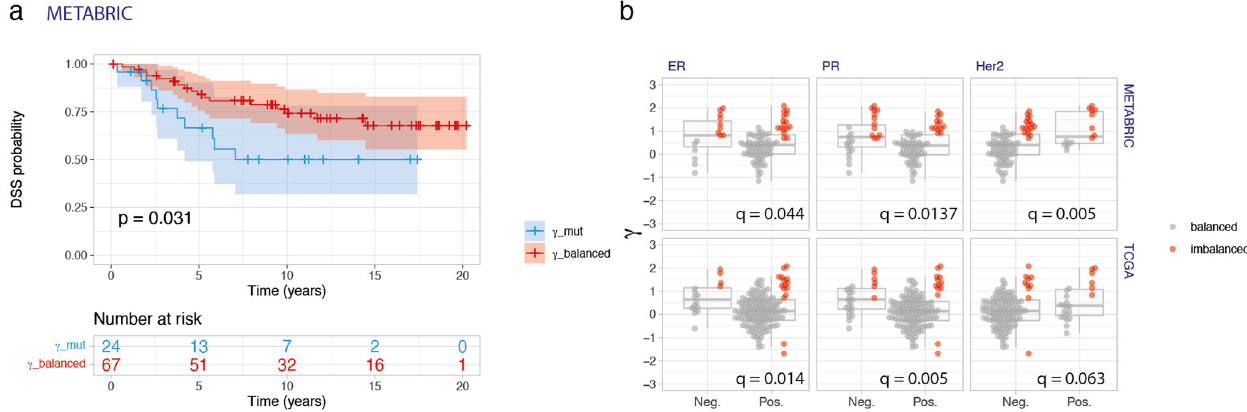
Fig. 3 Allelic preferential expression of PIK3CA mutations is associated with survival and clinicopathological parameters in breast cancer. a Kaplan – Meier curve of disease-speci fi c survival showing the worse prognosis of patients with differential expression of the PIK3CA mutations ( γ mut group, shown in blue) compared to those expressing equimolar levels of mutation and wild-type alleles ( γ balanced group, shown in red), in METABRIC. Shown below the graph are the numbers of patients at risk per group throughout time. b Preferential expression of the mutated allele is associated with ER-negative, PR-negative, and Her2-positive breast tumors. In all graphs, samples were colored according to the signi fi cance of the allelic expression imbalance. q values indicated correspond to the Wilcoxon rank-sum test with continuity correction, corrected for multiple testing using the Benjamini & Hochberg method. Survival plots indicate the 95%CI as colored shades. Boxplots display the median, the lower and upper hinges corresponding to the fi rst and third quartiles, and lower and upper whiskers corresponding to the smallest and largest values from the 1.5 * IQR (interquartile range), respectively. npj Breast Cancer (2022)